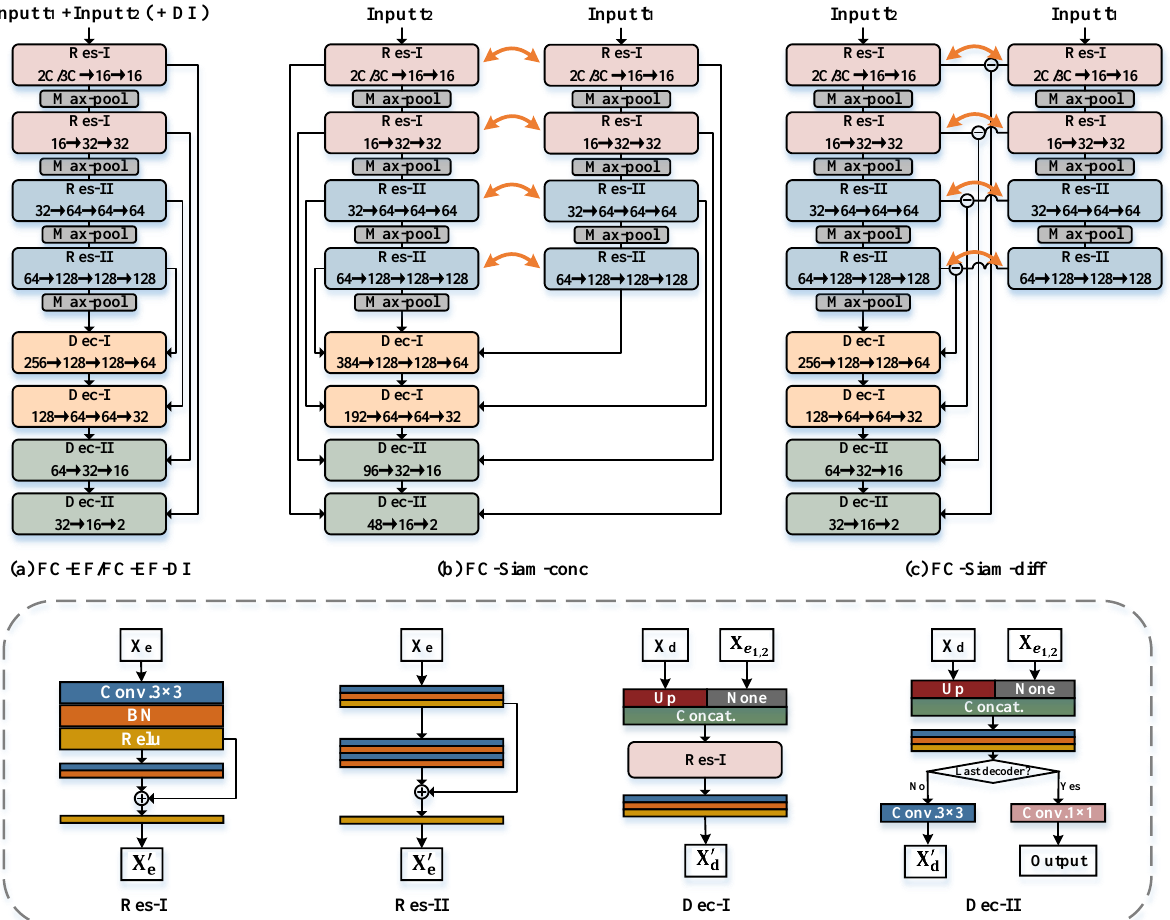
Figure 2. Our implementation of three different change detection frameworks proposed by Caye Daudt et al.(2018) . Two types of residual blocks and encoder modules are used. X e represents the input features from the last layer and X e′ represents the output features at the encoding stage. X d , X d′ has a similar denotion to X e , X e′ but belong to the decoding stage. X e encoder multi-temporal outputs. Orange arrows illustrate weight